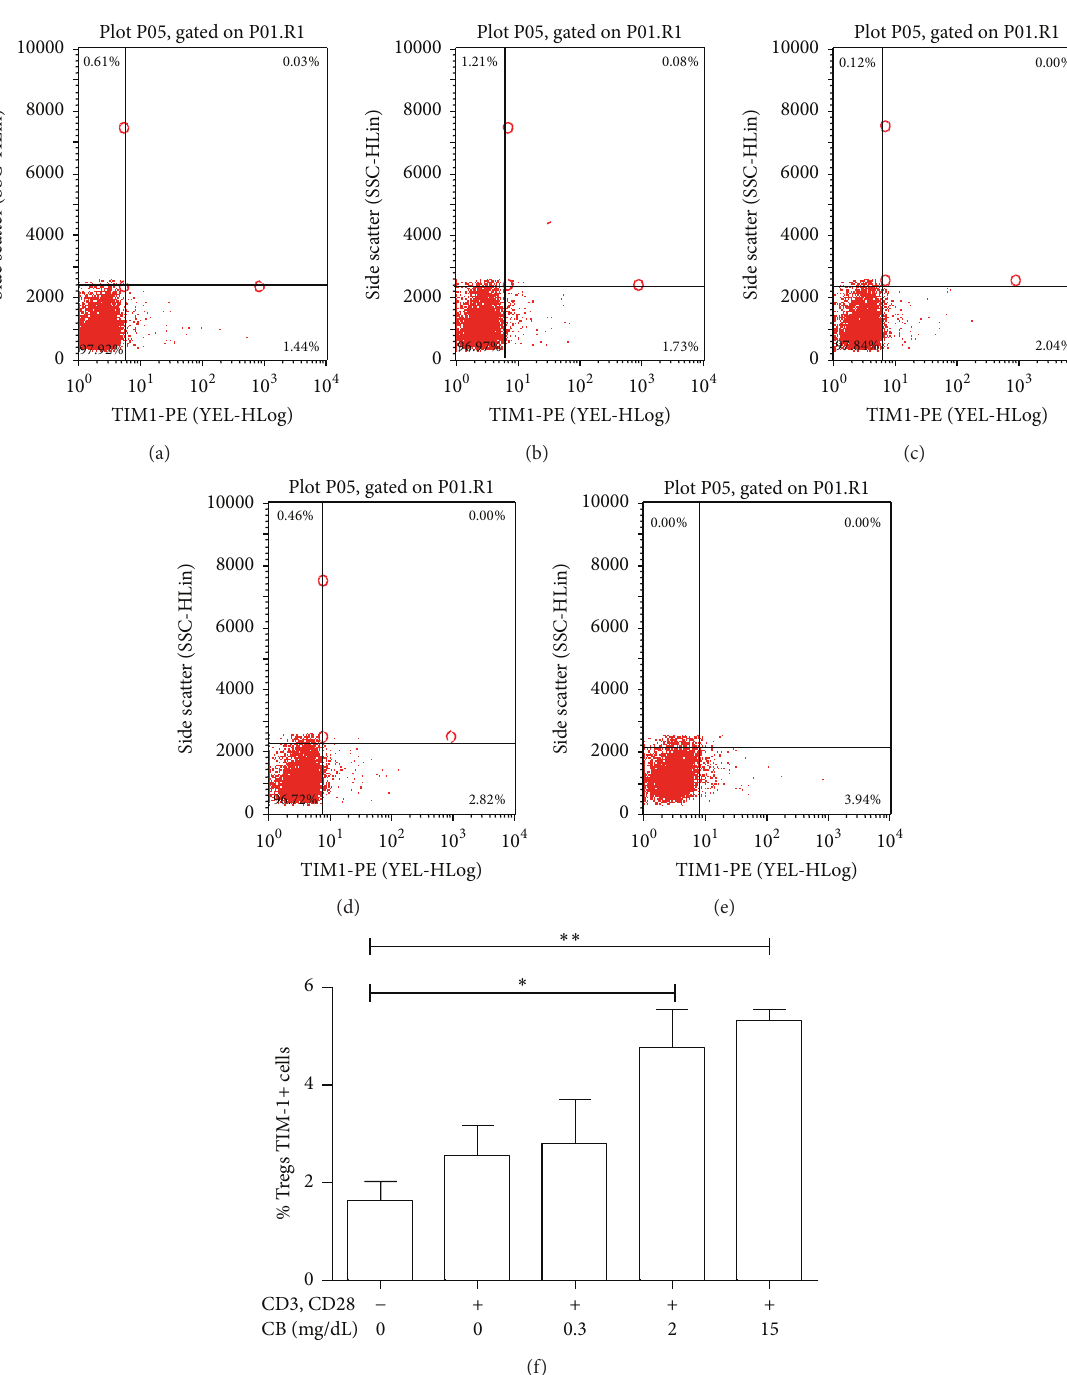
Figure 5: CB in vitro induces an augment in the percentage of Tregs expressing TIM-1. Purified Tregs from pediatric healthy donors were incubated at 37 ∘ C, 5% CO 2 with different concentrations of CB for 72 h. Then, cells were recovered and stained with anti-TIM-1-PE and the percentageofTregsexpressingTIM-1wasanalyzedbyusingflowcytometry.Representativedotplotsareshown.(a)Tregswithoutstimulus.(b) Tregs stimulated with anti-CD3 and anti-CD28. (c) Tregs stimulated with anti-CD3, anti-CD28 and CB (0.3 mg/dL). (d) Tregs stimulated with anti-CD3, anti-CD28, and CB (2 mg/dL). (e) Tregs stimulated with anti-CD3, anti-CD28, and CB (15 mg/dL). (f) The results are presented as TIM-1 percentage. The medians and SD of three independent experiments are shown. Nonparametric Kruskal-Wallis for comparison between groups was used to calculate statistical significance. ∗ 𝑃 < 0.05 was considered statistically significant. ∗∗ 𝑃 < 0.001